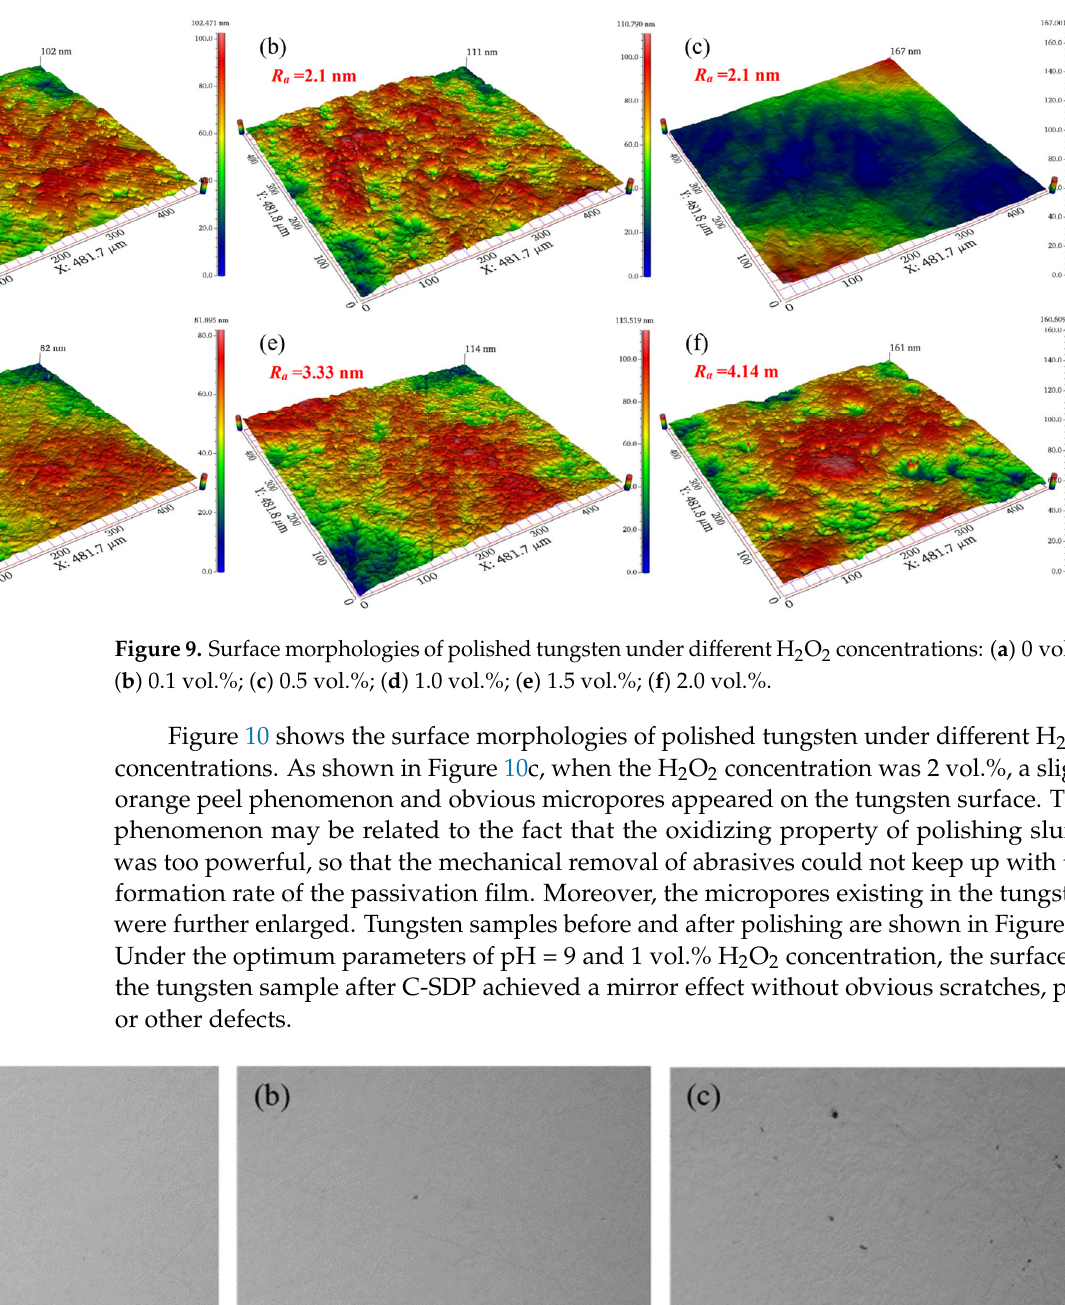
9 of 17 Figure 8. Effect of H 2 O 2 concentrations on removal rate and surface roughness: ( a ) material removal rate; ( b ) surface roughness.